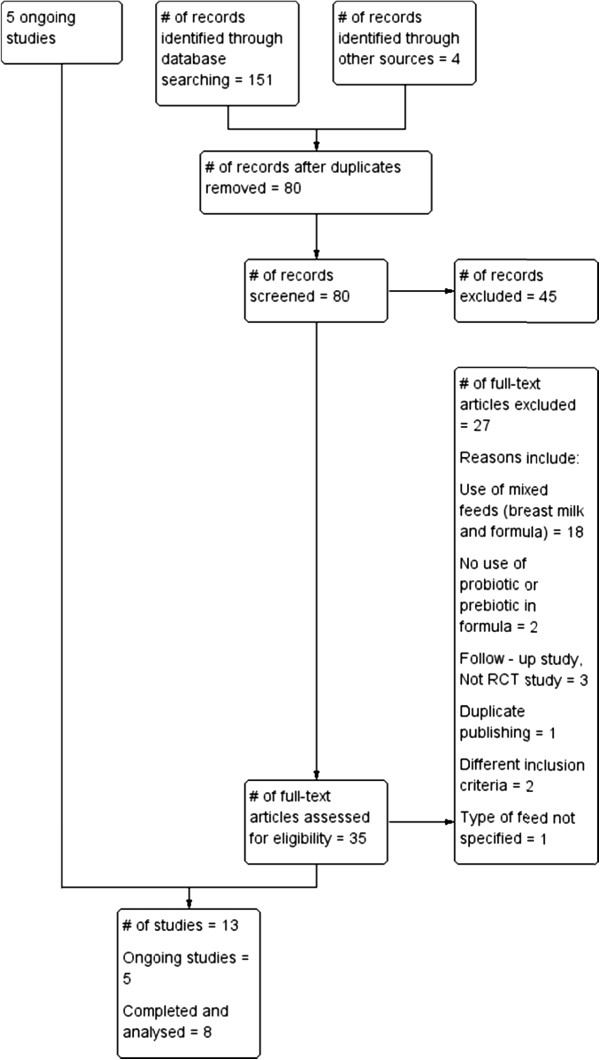
Process followed in the selection of studies.